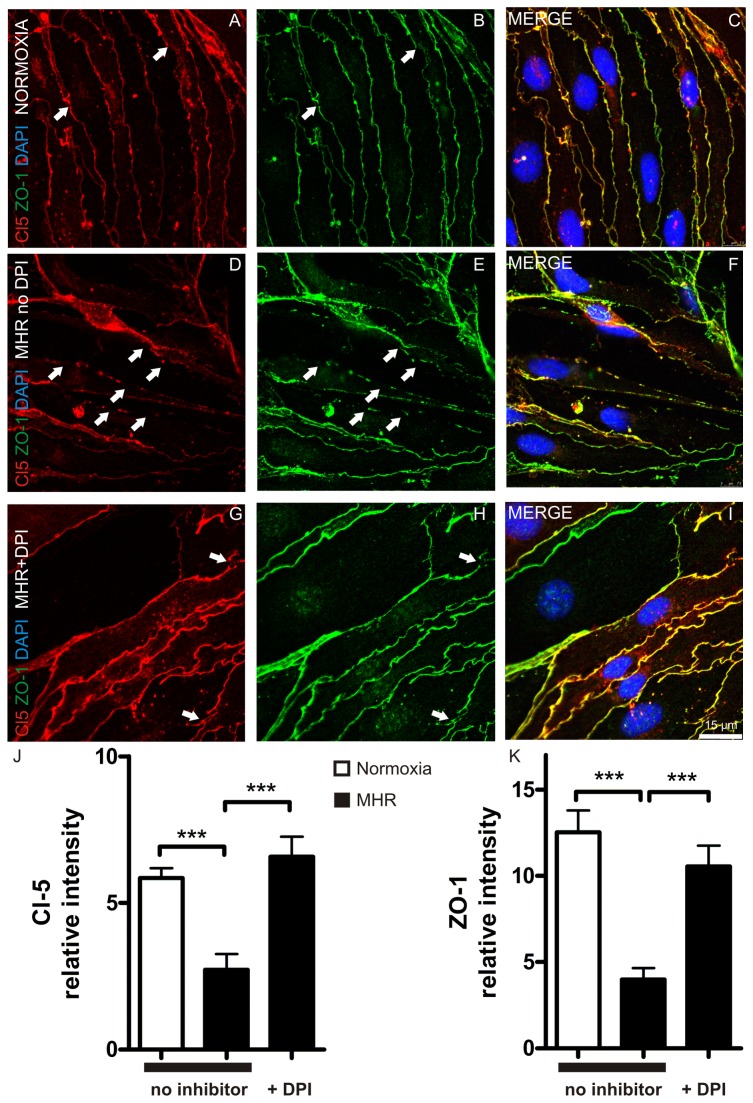
MHR disrupts BEC integrity on the level of tight junction proteins.BEC displayed a physiological arrangement of TJ proteins Claudin 5 (A) and zonula occludens 1 (B) in a co-localizing manner (C) with only few TJ gaps (arrowheads). MHR disrupted the continuous arrangement of both junctional proteins in BEC (arrowheads D-F). Here, DPI blocked TJ injury in MHR, only few TJ disruptions were detected in BEC pre-treated with the NADPH oxidase inhibitor DPI (arrowheads G-I). Representative images from 3 experiments per group are shown. Quantitative analyses of Cl5 (Cl5 normoxia: 5.85 + 0.33 vs. Cl5 MHR: 2.72 + 0.54, P < 0.0001; n = 12 cells per group from 3 experiments, J) and ZO-1 (ZO-1 normoxia: 12.53 + 1.27 vs. ZO-1 MHR: 3.98 + 0.67, P < 0.0001; n = 12 cells per group from 3 experiments, K) integrity on cell membranes revealed that both junctional proteins are significantly perturbed in MHR. DPI pre-treatment significantly restored TJ integrity at cellular membranes under MHR (Cl5 MHR: 2.72 + 0.54 vs. Cl5 MHR+DPI: 6.57 + 0.69, P = 0.0002; ZO-1 MHR: 3.98 + 0.67 vs. ZO-1 MHR+DPI 10.55 + 1.21, P < 0.0001; n = 12 cells per group from 3 experiments).